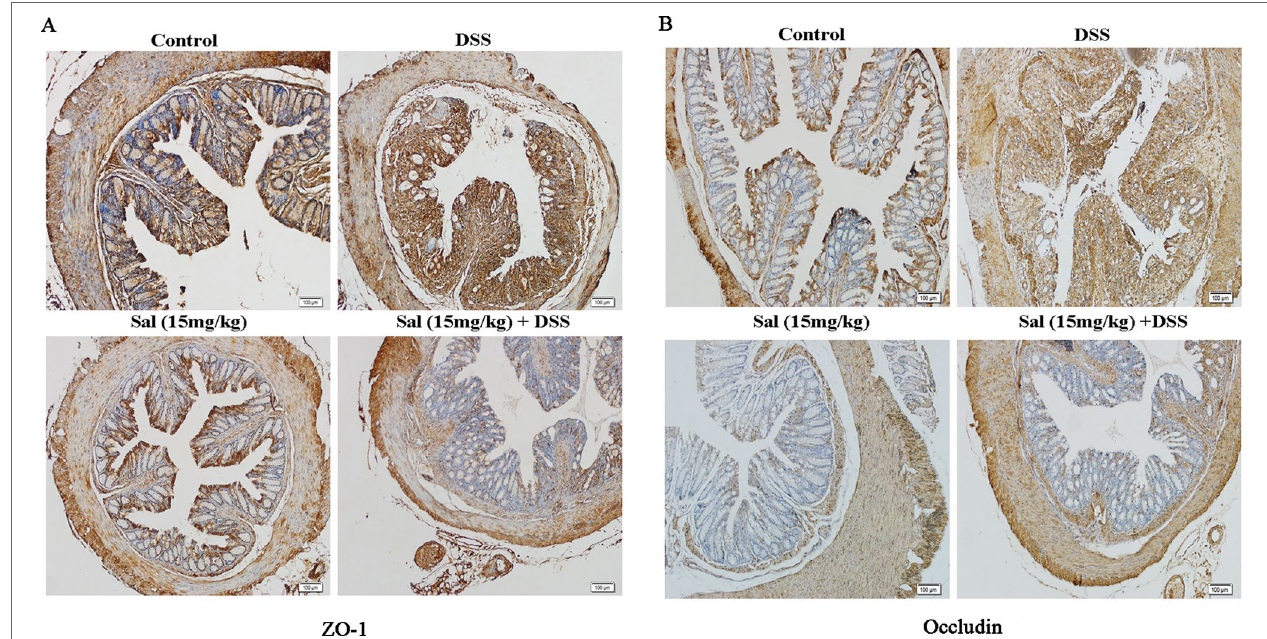
FIgURe 6 | Salidroside contributed to the maintenance of tight junction architecture in dextran sulfate sodium-treated mice. (A) and (B) Immunohistochemistry for zonula occludens-1 and occluding in the colonic tissue, respectively. (400×; scale bar, 100 μm).